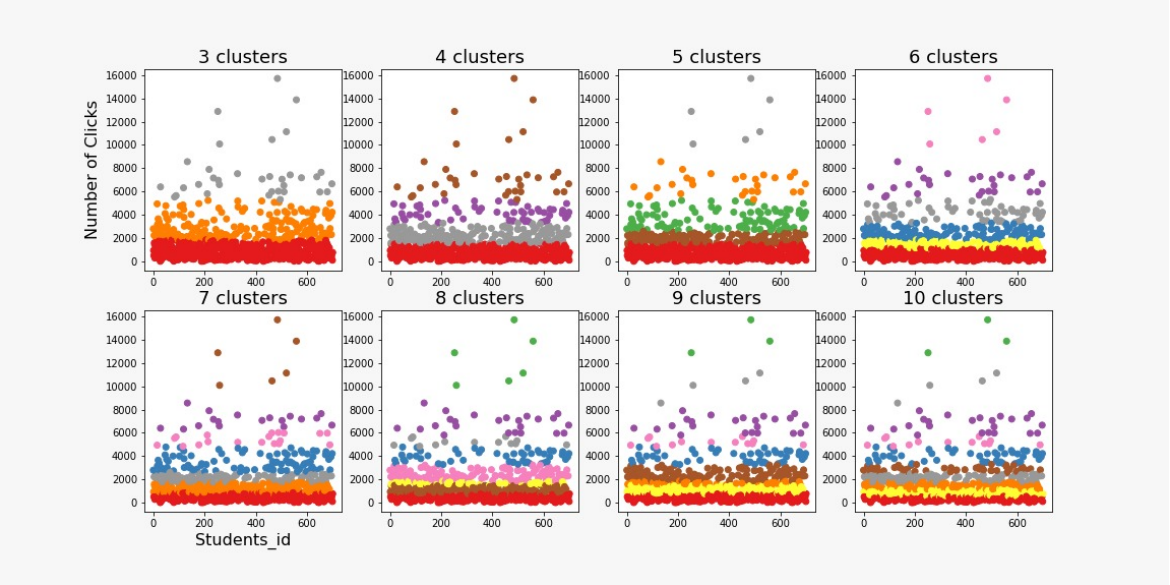
Figure 2 Clustering Using the Expectation Maximization Algorithm